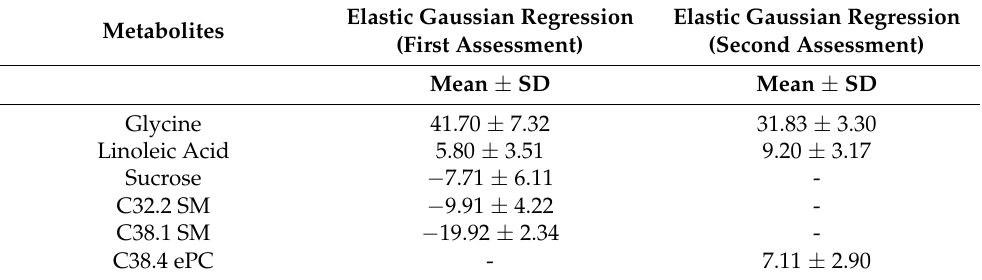
Table 2. List of coefficients of metabolites selected 10 times in the ten times iterated 10-fold-cross validation of the elastic continuous regression analyses in the whole Satiety Innovation (SATIN) dataset and including the two satiety assessments.